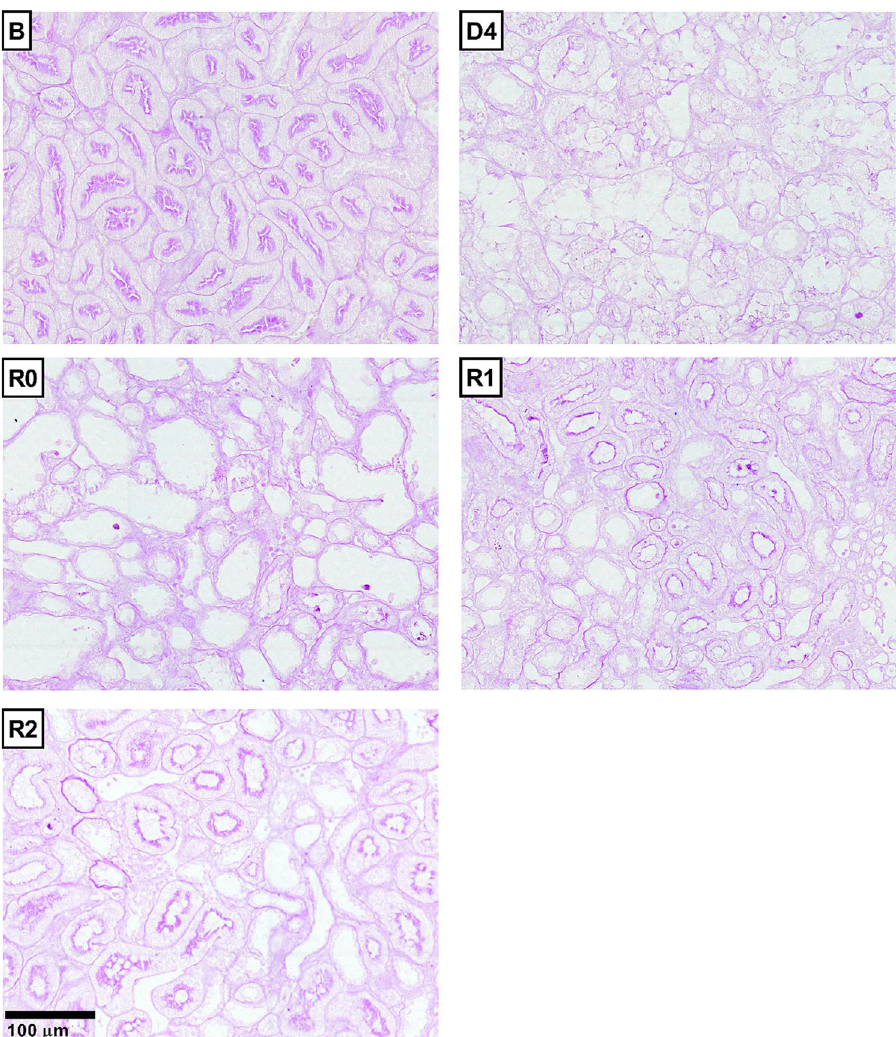
Figure 3. Renal histology: brush border membrane disorganization. Periodic Acid-Schiff staining in control group, D4, R0, R1 and